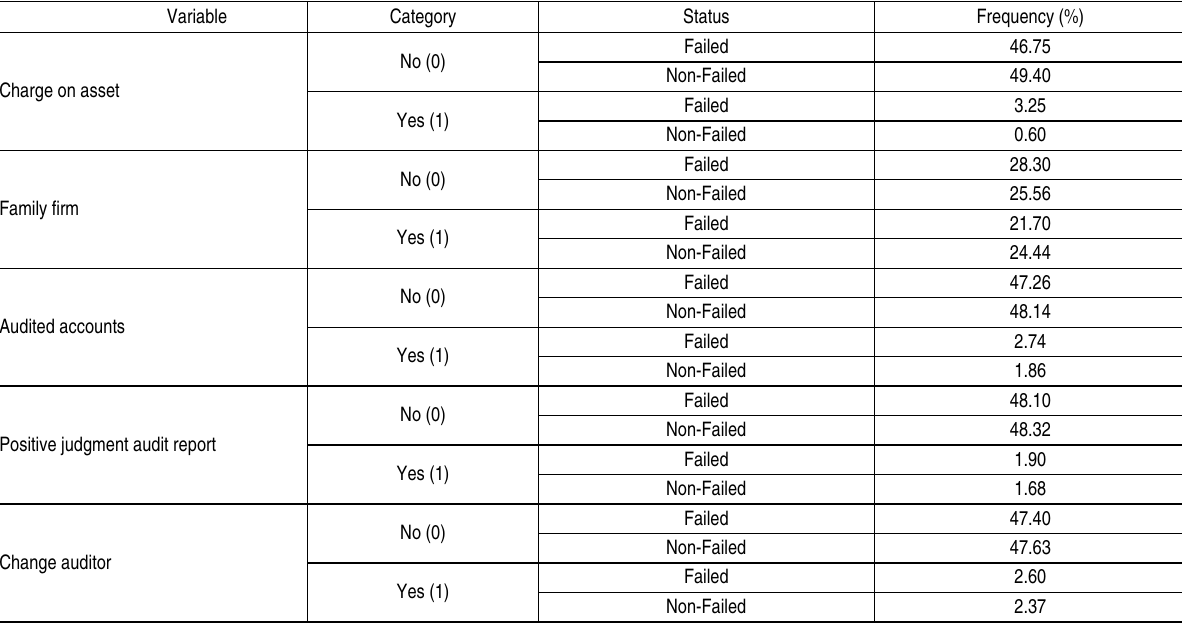
Table A.2. Descriptive statistics of the qualitative predictor variables